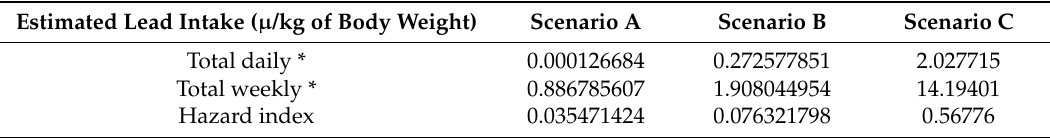
Table 7. Baroševac adult population’s lead intake and index hazard (semi-probabilistic method). Estimated Lead Intake ( µ /kg of Body Weight)